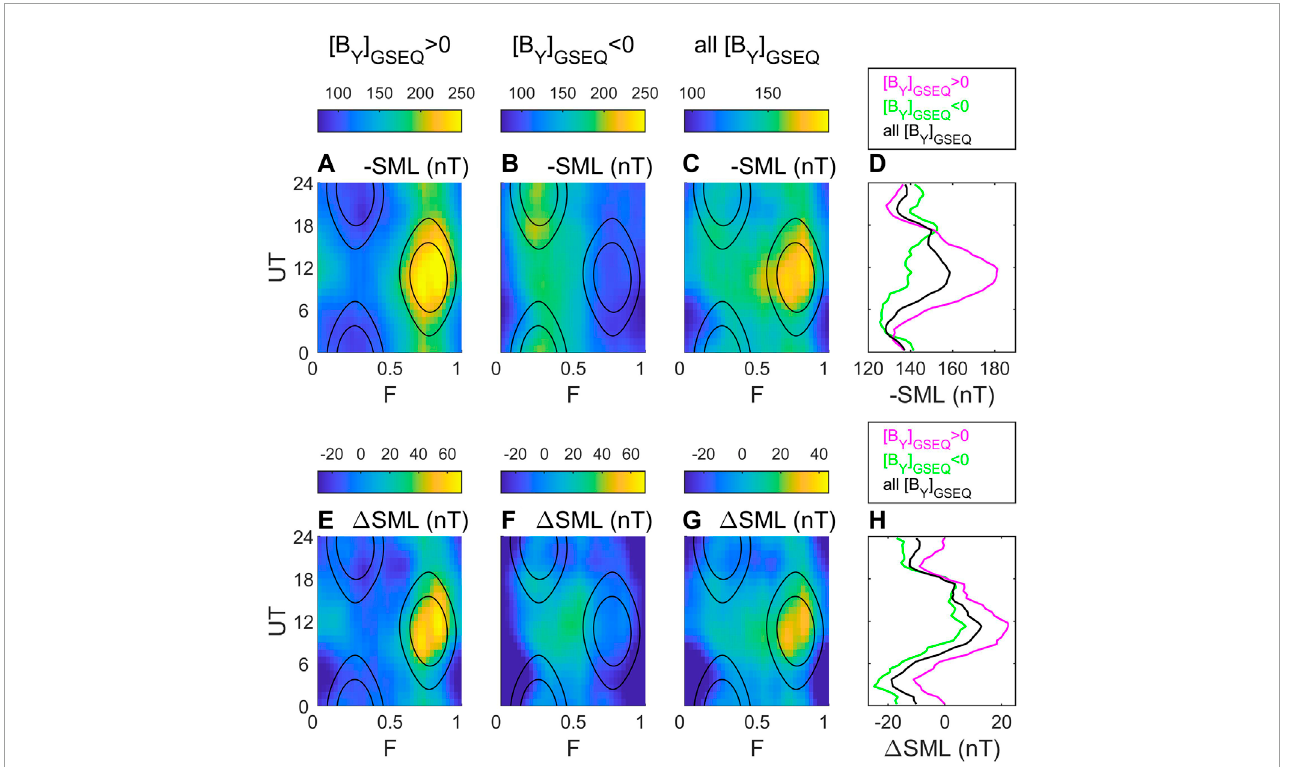
FIGURE 10 F-UT plots of the -SML index. Parts (A–D) show the means of − SML , parts (E–H) show means of Δ SML = SML p − SML , where SML p is computed from Φ D using the linear fit given by Eq. 1 . The two contours on each F-UT plot are as shown in Figure 7 and define the R-M peaks in the IMF orientation factor in Φ D , sin 2.5 ( θ /2). From right to left the first column is for [ B Y ] GSEQ > 0, the second for [ B Y ] GSEQ < 0 and the third for all [ B Y ] GSEQ . The right-hand plots (D,H) show the averages of the index over all F as a function of UT : the green line is for [ B Y ] GSEQ > 0, the mauve line for [ B Y ] GSEQ < 0 and the black line for all [ B Y ] GSEQ . Data are for 1980–2021,